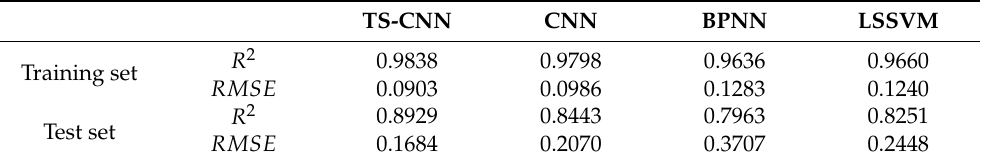
Figure 7. ( a ) Training results of the TS-CNN model. ( b ) Testing results of different models. Table 4. 𝑅 (cid:2870) and 𝑅𝑀𝑆𝐸 for each model.